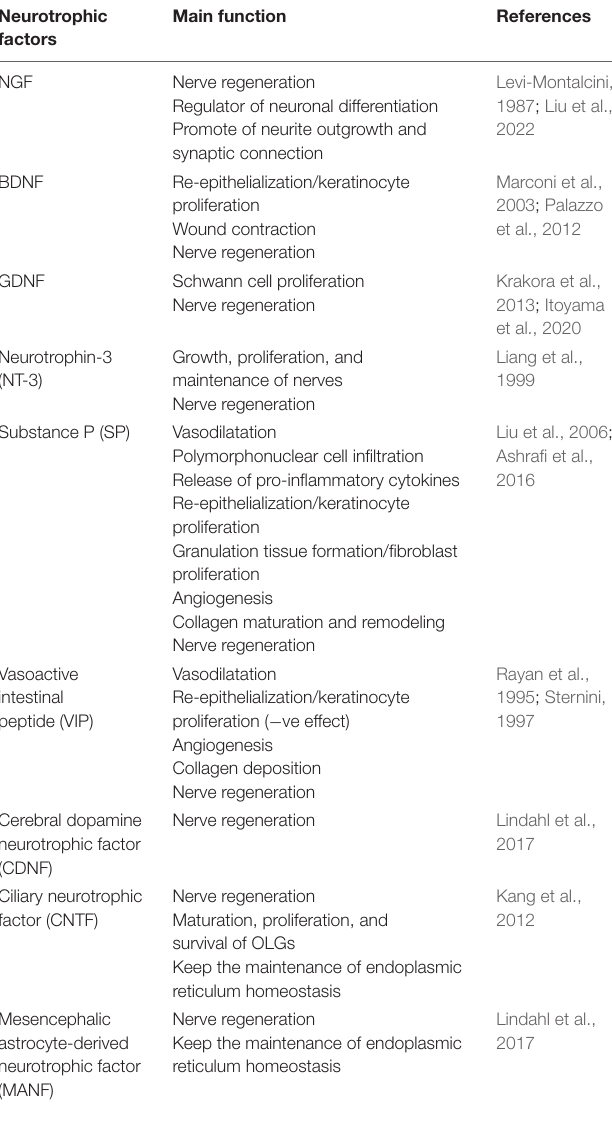
TABLE 3 | The role of neurotrophic